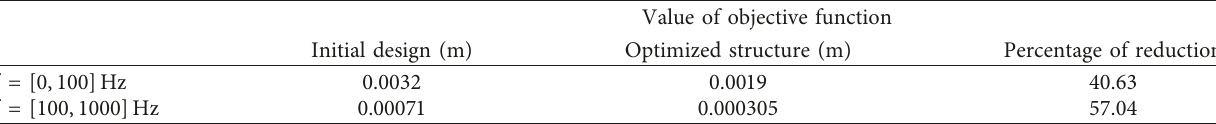
Figure 9: The convergence histories of the objective function. (a) f Table 3: The comparison of objective functions before and after